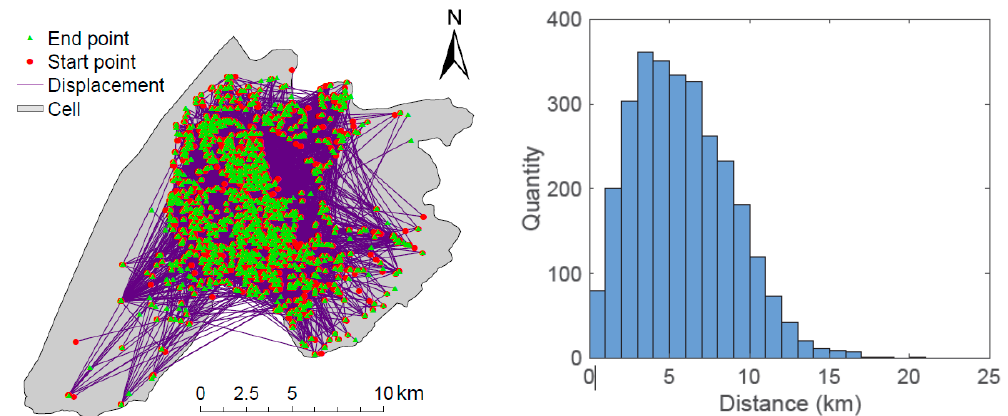
Figure 3. Displacements (significance < 0.01) and histogram of the distances.